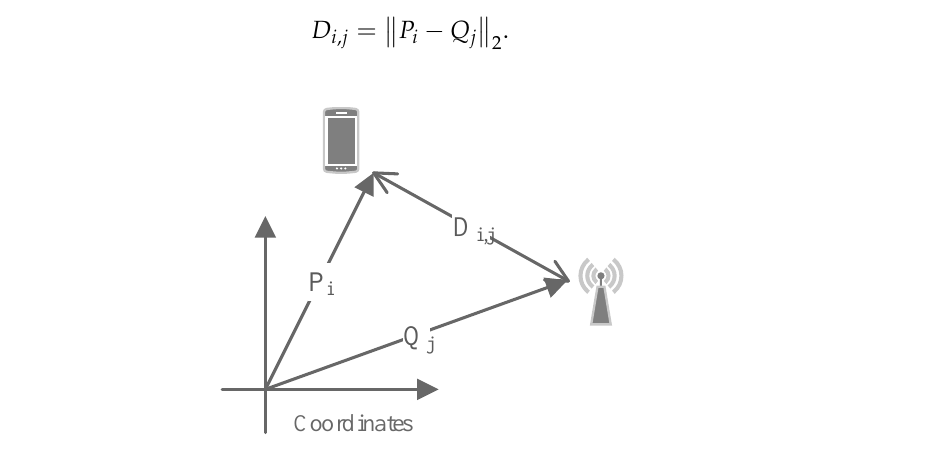
Figure 2. The relations among the location of the observation (denoted as P i ), the location of the AP (represented as Q j ) and the distance between the two locations (denoted as D i , j